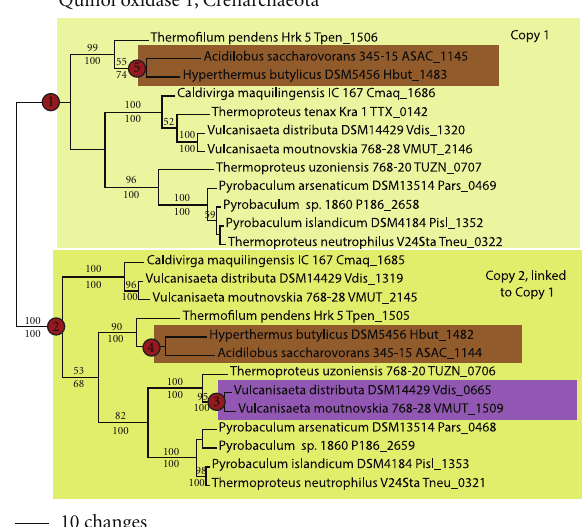
Figure 5: Cytochrome bd quinol oxidase in the Crenarchaeota. Phylogenetic tree for quinol oxidase subunit